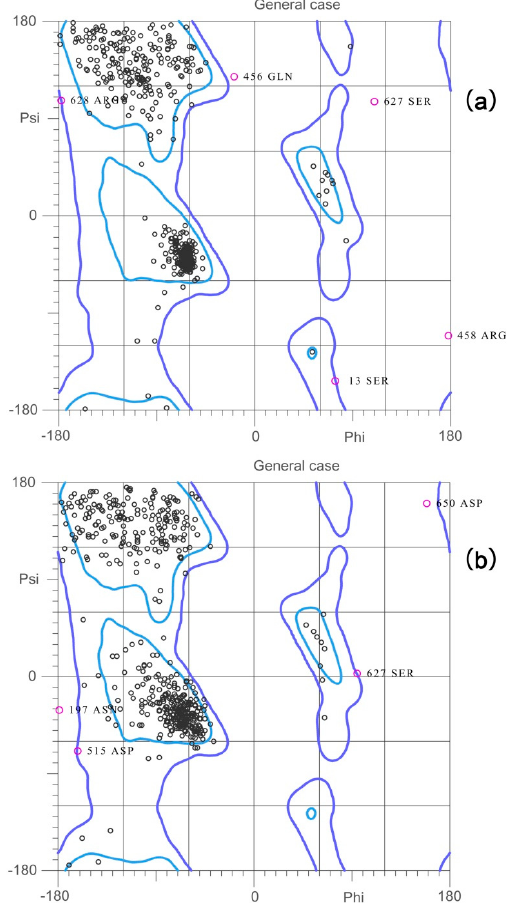
Figure 2. Ramachandran plots of ( a ) initial 3D structure and ( b ) final 3D structure of BaThrRS.